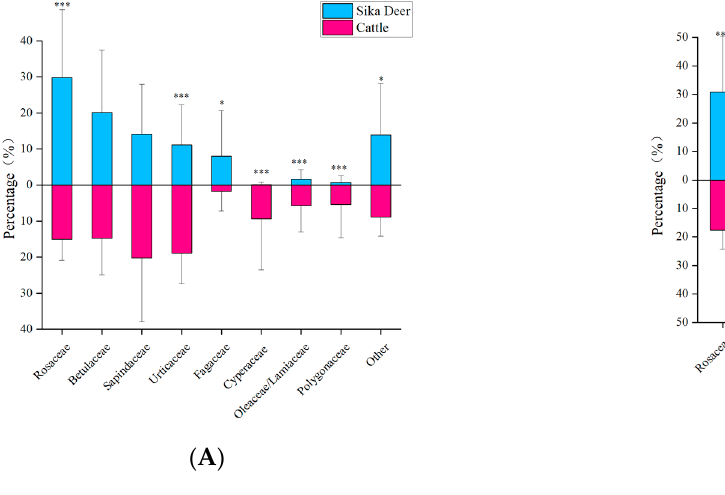
Figure 3. ( A )The main food in the diet of cattle and sika deer from Tiangen. ( B ) The main food in the diet of cattle and sika deer from Tsingke. Families with less than 5% dietary share were classified as “Other”. Significance between two species of the same family was compared and statistically significant differences are shown. *, 0.01 < p < 0.05; ***, p < 0.01.